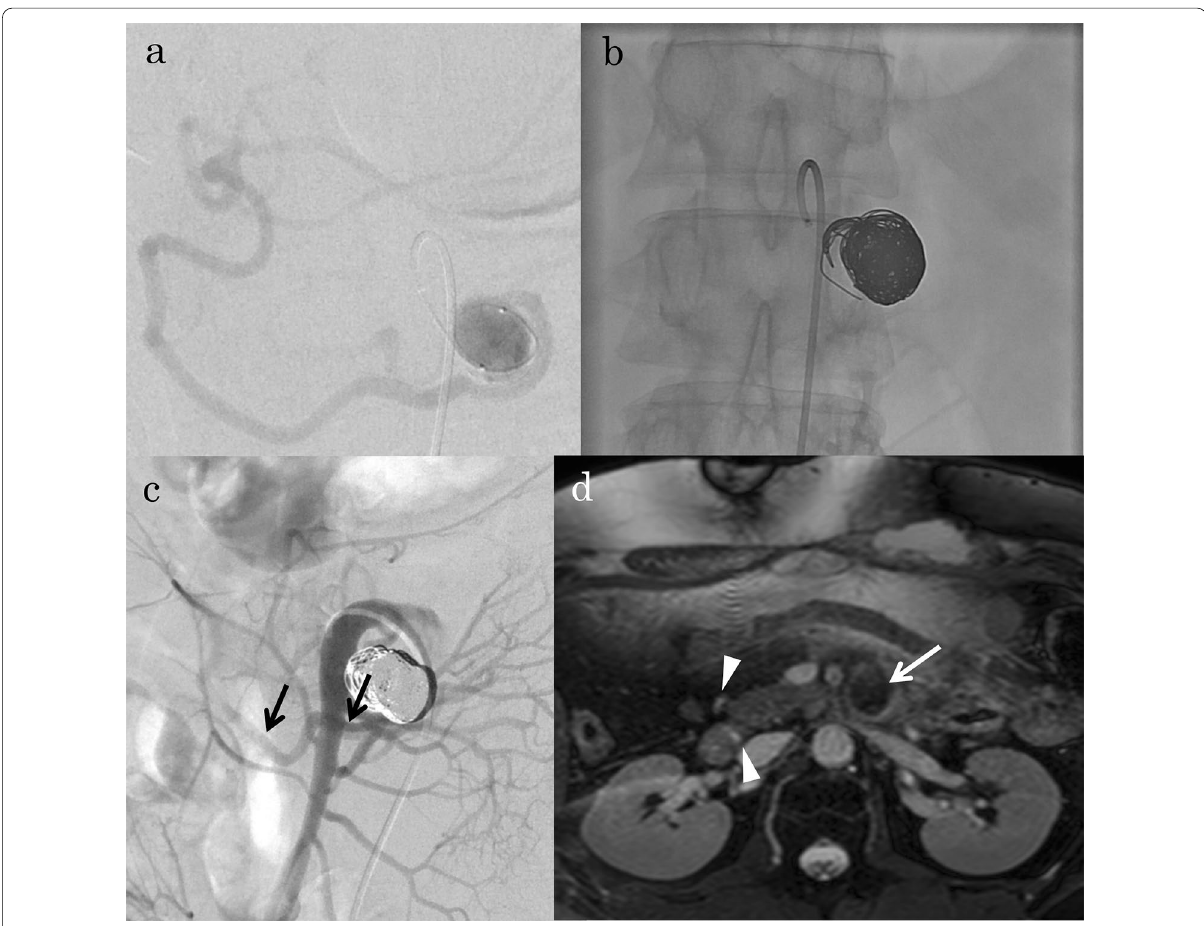
Fig. 6 Images from Case 2. a Intra-aneurysmal angiogram immediately before coil embolization showing opacification of the distal inferior pancreaticoduodenal artery (PDA). b Fluoroscopic images during coil embolization showing coil packing of the inferior PDA aneurysm (PDAA). c Post-embolization angiogram via the superior mesenteric artery showing complete occlusion of the aneurysm with excellent preservation of the inferior PDA (black arrows). d Non-contrast-enhanced magnetic resonance imaging after treatment showing disappearance of the flow in the PDAA (white arrow) and decreased thickness of the pancreatic arcades (white